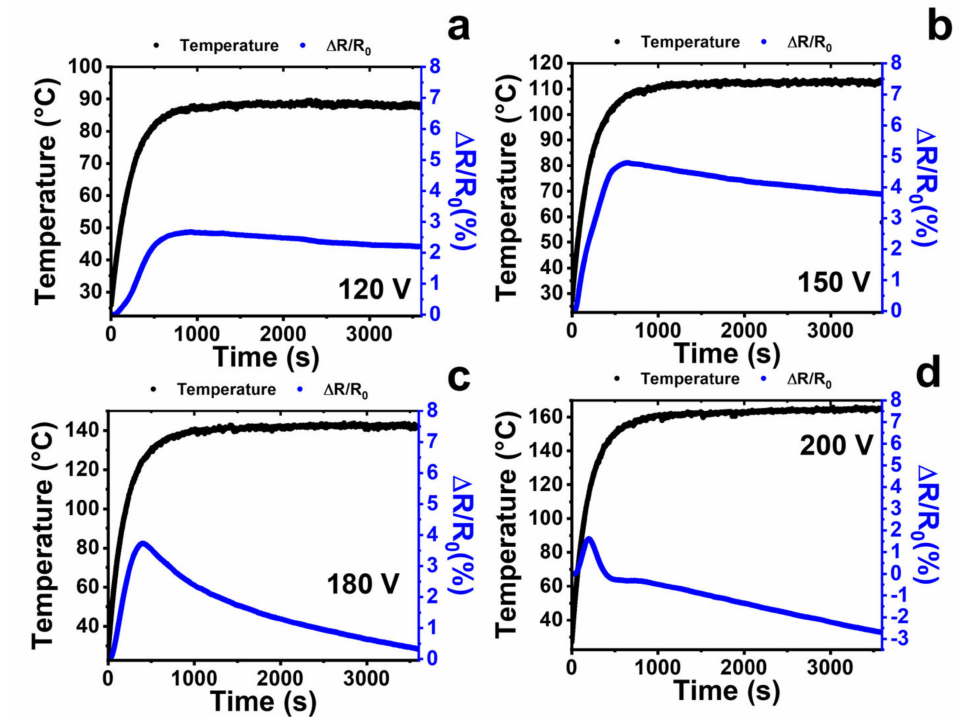
Figure 12. ( a ) Temperature behavior (i.e., temperature left vertical axis) and resistance variation (i.e., ∆ R/R 0 , right vertical axis) vs. the heating time at an applied voltage value of ( a ) 120 V; ( b ) 150 V; ( c ) 180 V; ( d ) 200